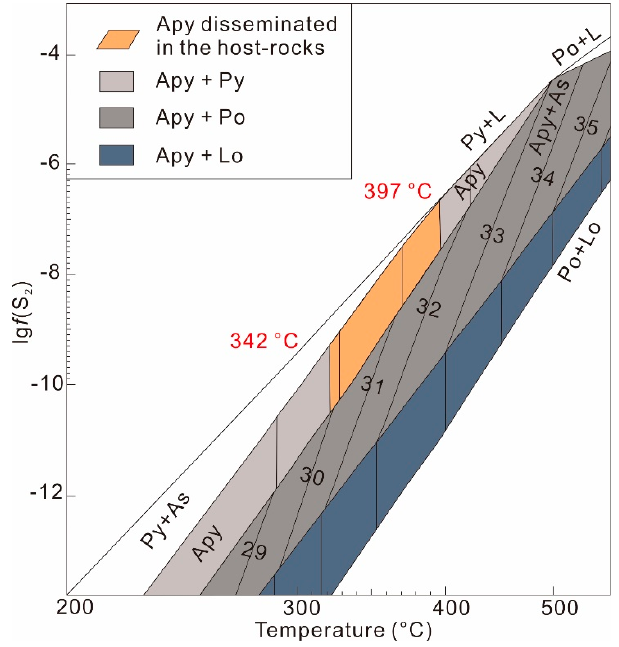
Figure 9. Activity of lg f (S 2 ) and temperature (T) projection of the stability field of arsenopyrite [14,39].